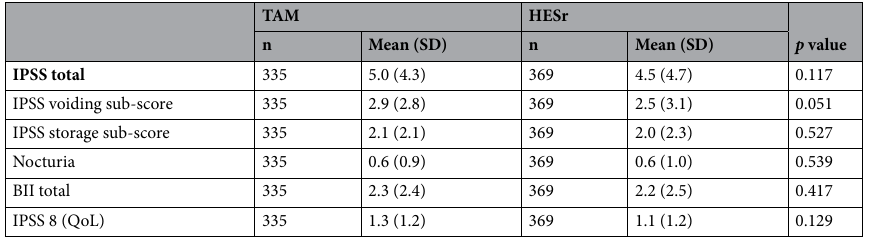
Table 2. Improvements from baseline to 6-month follow-up in symptoms and quality of life by treatment group (iterative matching sample). TAM: tamsulosin; HESr : hexanic extract of Serenoa repens; IPSS: International Prostate Symptom Score; BII: Benign Prostatic Hyperplasia Impact Index; QoL: quality of life.